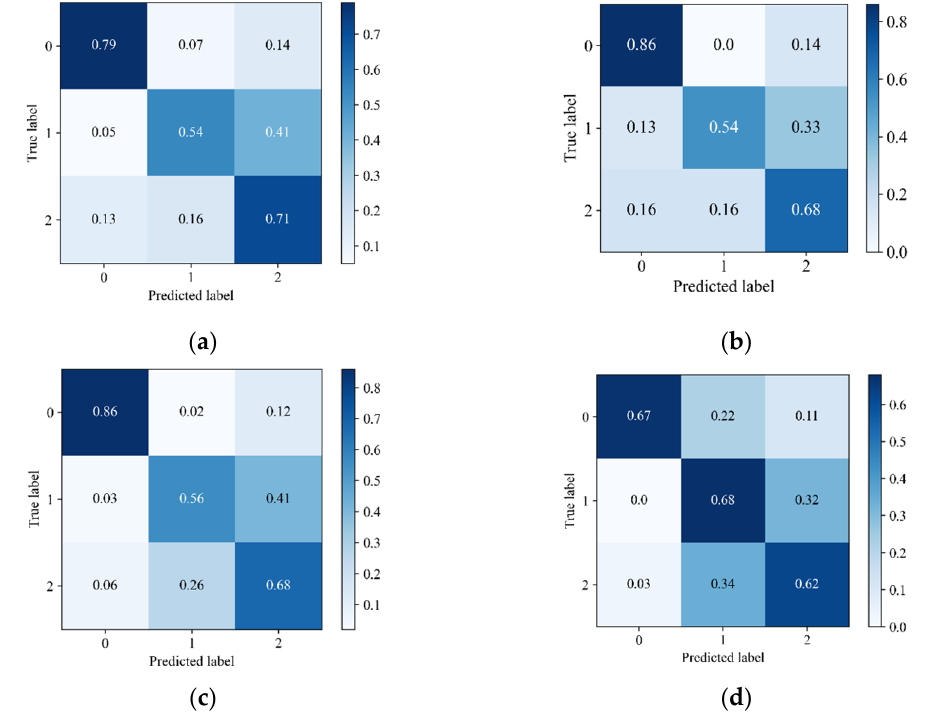
Figure 10. Confusion matrix of different machine learning methods: ( a ) ANN; ( b ) NB; ( c ) XGBoost; ( d ) XGBoost_NoSmote.